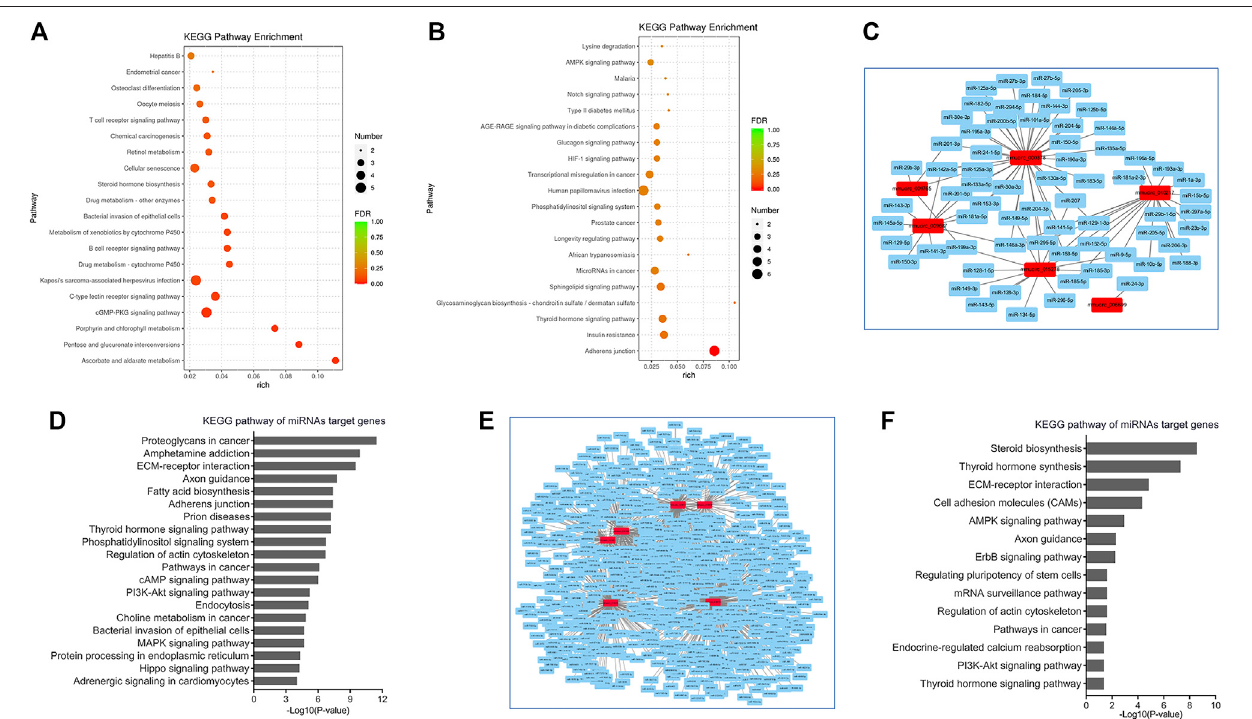
FIGURE 5 | Bioinformatic analysis of circRNAs in viral myocarditis. (A,B) Kyoto Encyclopedia of Genes and Genomes (KEGG) pathway analyses for cis-target genesofA/J-speci fi c (A) andC57BL/6-speci fi c (B) dysregulatedcircRNAs. (C) CircRNA-miRNAs networksforA/J-speci fi cdysregulatedcircRNAs. (D) KEGGpathway analyses formiRNAstargeted byA/J-speci fi cdysregulated circRNAs. (E) CircRNA-miRNAs networksfor C57BL/6-speci fi cdysregulated circRNAs. (F) KEGG pathway analyses for miRNAs targeted by C57BL/6-speci fi c dysregulated circRNAs.